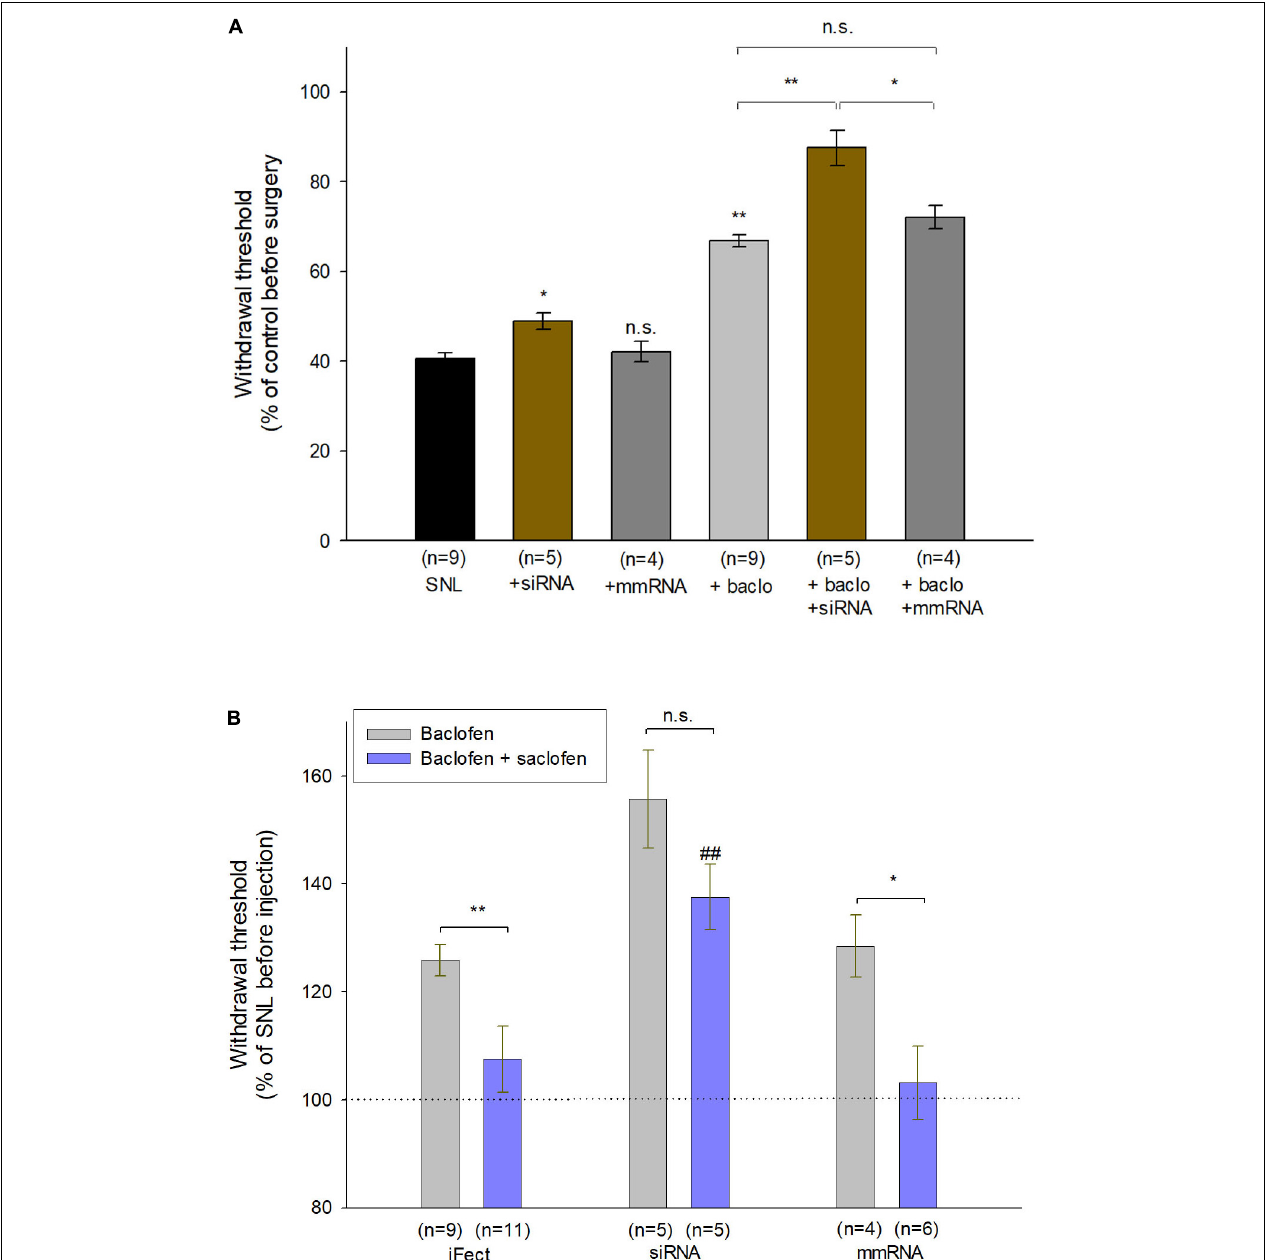
FIGURE 8 | Intrathecal injection of anti-fibulin-2 siRNA potentiates the antinociceptive effect of baclofen in neuropathic rats. (A) Effects of anti-fibulin-2 siRNA and baclofen injections in SNL rats. The effects are quantified with or without baclofen, and before (SNL, SNL + baclo) or after (SNL + siRNA, SNL + baclo + siRNA) intrathecal injections of anti-fibulin-2 siRNA or mismatch RNA (SNL + mmRNA, SNL + baclo + mmRNA). Threshold to mechanical stimulation was measured with the von Frey test. In the absence of baclofen, the injection of anti-fibulin-2 siRNA, but not mmRNA, induces an analgesic effect per se (* p < 0.05 “SNL” vs. “SNL + siRNA”). Baclofen displayed an antinociceptive effect in SNL rats (** p < 0.01 “SNL” vs. “SNL + baclo”). Anti-fibulin-2 siRNA potentiated the antinociceptive effect of baclofen in SNL rats (** p < 0.01 “SNL + Baclo” vs. “SNL + baclo + siRNA”). The withdrawal threshold remained unchanged after injection of mismatch RNA. The withdrawal threshold before nerve ligation was set to 100%. * p < 0.05; ** p < 0.01; n.s.: p > 0.05. (B) Effects of baclofen and saclofen co-application after injections of iFect (control condition), anti-fibulin-2 siRNA (siRNA) or mismatch RNA (mmRNA) in neuropathic rats. Saclofen inhibited the baclofen effect before anti-fibulin-2 siRNA injection (** p < 0.01 “baclofen” vs. “baclofen + saclofen”). This effect of saclofen is abolished after anti-fibulin-2 siRNA injections (n.s.: p > 0.05, siRNA, “baclofen” vs. “baclofen + saclofen”) but not after mmRNA injection (* p < 0.05, mmRNA, “baclofen” vs. “baclofen + saclofen”). After anti-fibulin-2 siRNA injection, the withdrawal threshold was significantly higher than after iFect injection (## p < 0.01 siRNA “baclofen + saclofen” vs. iFect “baclofen + saclofen”). The withdrawal threshold in neuropathic rats before injection was set to 100%.